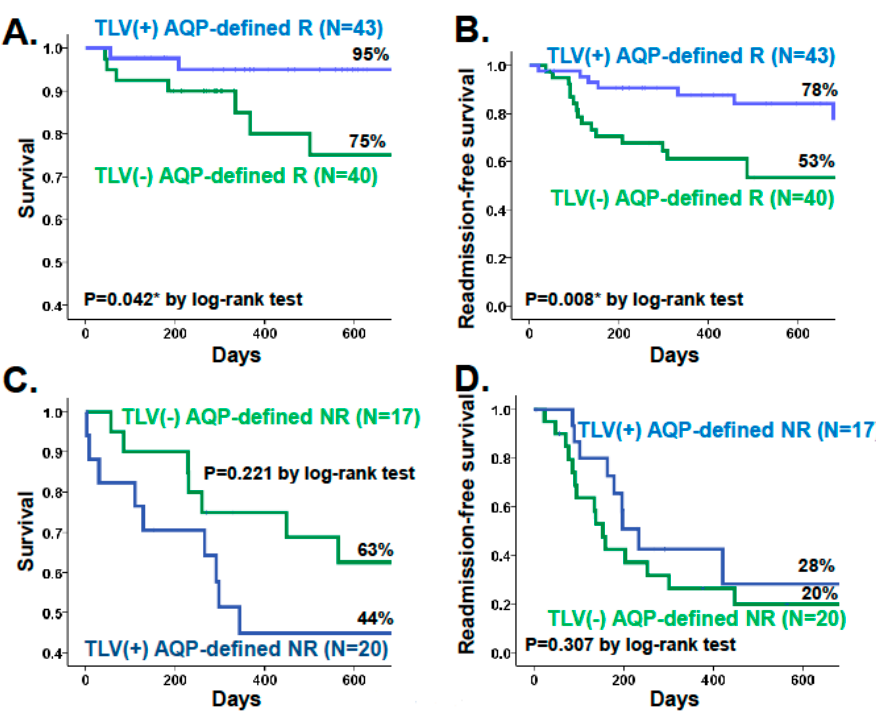
Figure 2. Kaplan-Meier curves showing survival and readmission-free survival rate stratified by the administration of tolvaptan in responders ( A , B ) and non-responders ( C , D ). R, responder; NR, non-responder; TLV, tolvaptan, AQP, aquaporin.